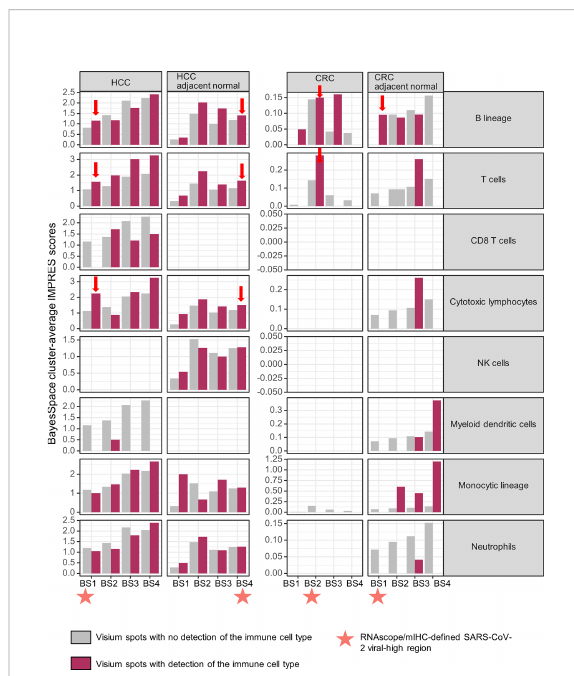
FIGURE 4 Spatial associations of immune cell types and immuno- predictive scores (IMPRES) in individual spatial transcriptomic niches. From left to right, BayesSpace (BS) clusters 1 – 4 in HCC, HCC-adjacent normal tissue, CRC, and CRC-adjacent normal tissue are shown. Each BS cluster was strati fi ed by the presence of the immune cell of interest (determined by a deconvolution- based microenvironment cell population-counter) as follows: B lineage, T cells, CD8 + T cells, cytotoxic lymphocytes, NK cells, myeloid dendritic cells, monocytic lineage, and neutrophils (from top to bottom). Orange stars indicate viral-high regions (transcriptomic niches with the highest SARS-CoV-2 spike protein/nucleocapsid protein counts); red arrows indicate higher IMPRES scores in Visium spots analyzed for B lineage cells, T cells, and cytotoxic lymphocytes within the viral-high